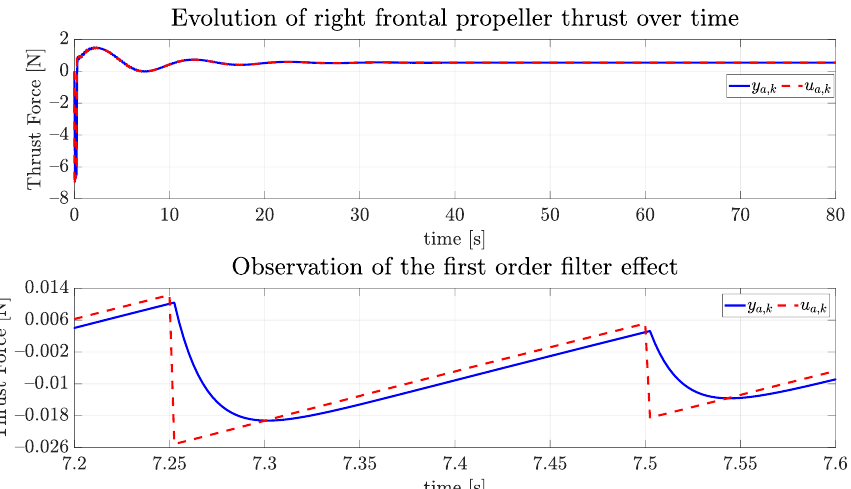
Figure 19. The evolution of one of the propellers over time and the effect of the first order system as the response of the